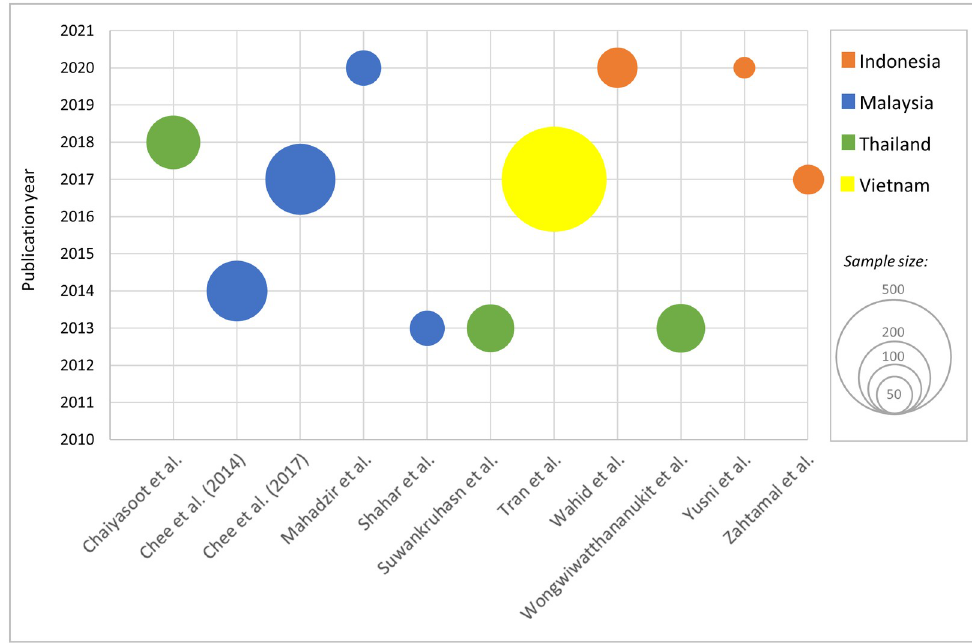
Fig 2. Bubble chart of each included study, its respective publication year and relative sample size.